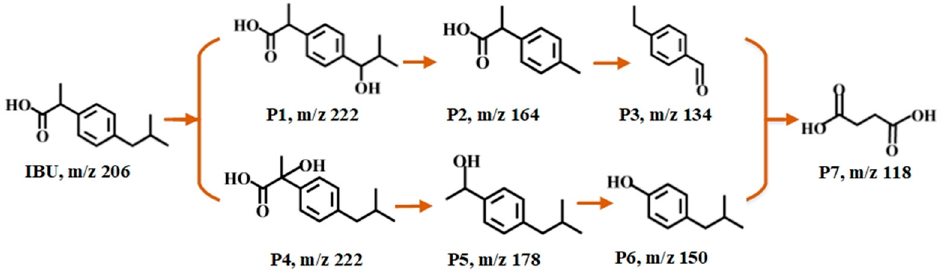
Figure 7. Degradation pathways of IBU in the EC/Fe 3+ /PDS